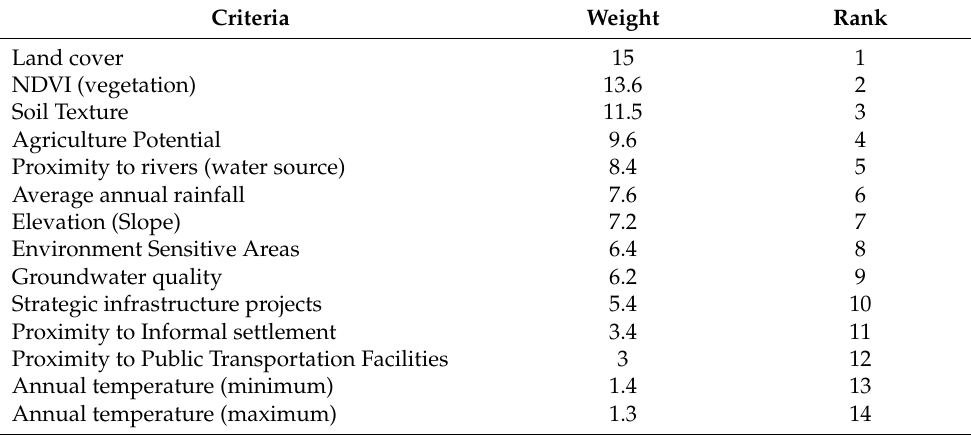
Table 3. Criteria to identify strategic land in